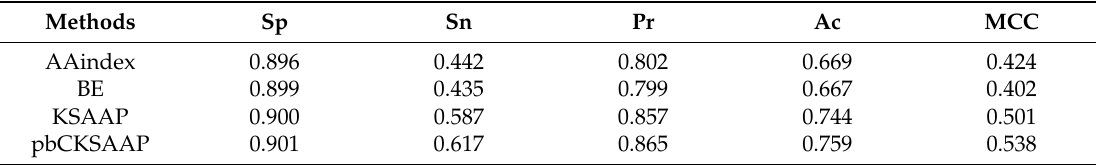
Table 6. Performance comparison with different sequence-based features. AAindex—amino acid